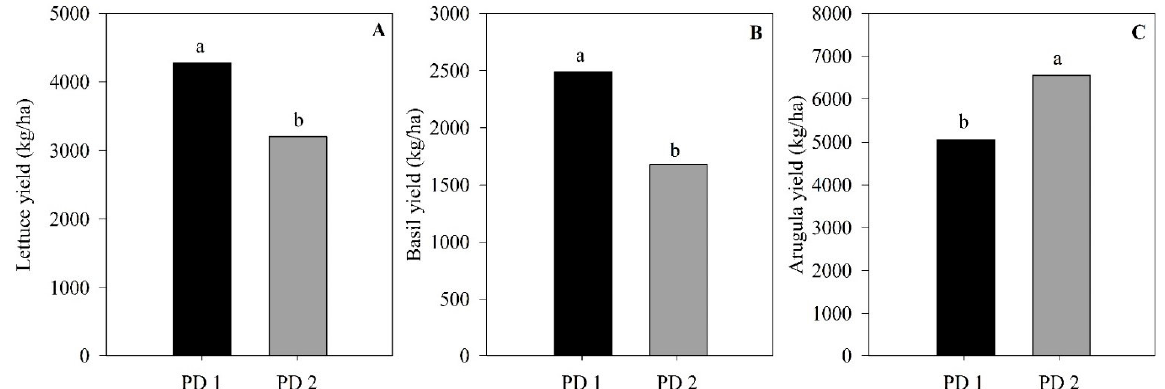
Figure 1. The main effects of two planting dates (PD) on the fresh weight yield of lettuce ‘Salanova Red Butter’ ( A ), basil ‘Genovese’ ( B ), and arugula ‘Astro’ ( C ) grown in high tunnels. Columns followed by the same letter(s) are not significantly different according to Tukey’s Honest Significant Difference Test ( p <